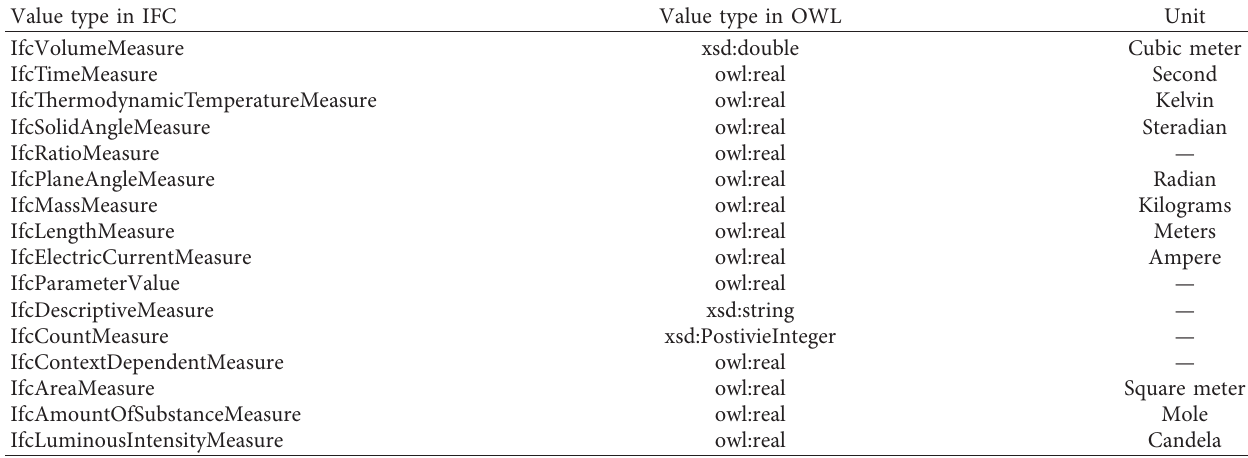
Table 1: The mapping relationship between data type in ifcOWL, the value type of NominalValue, and unit. Value type in IFC